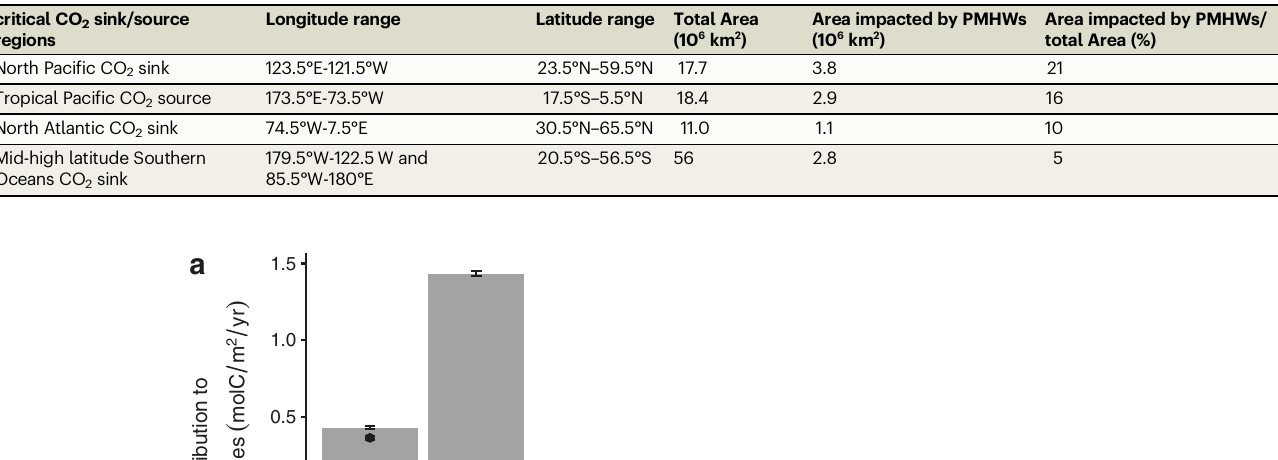
Table 1 | Ranges in longitude and latitude, total area, area and normalized area impacted by PMHWs of the four regions considered in this study